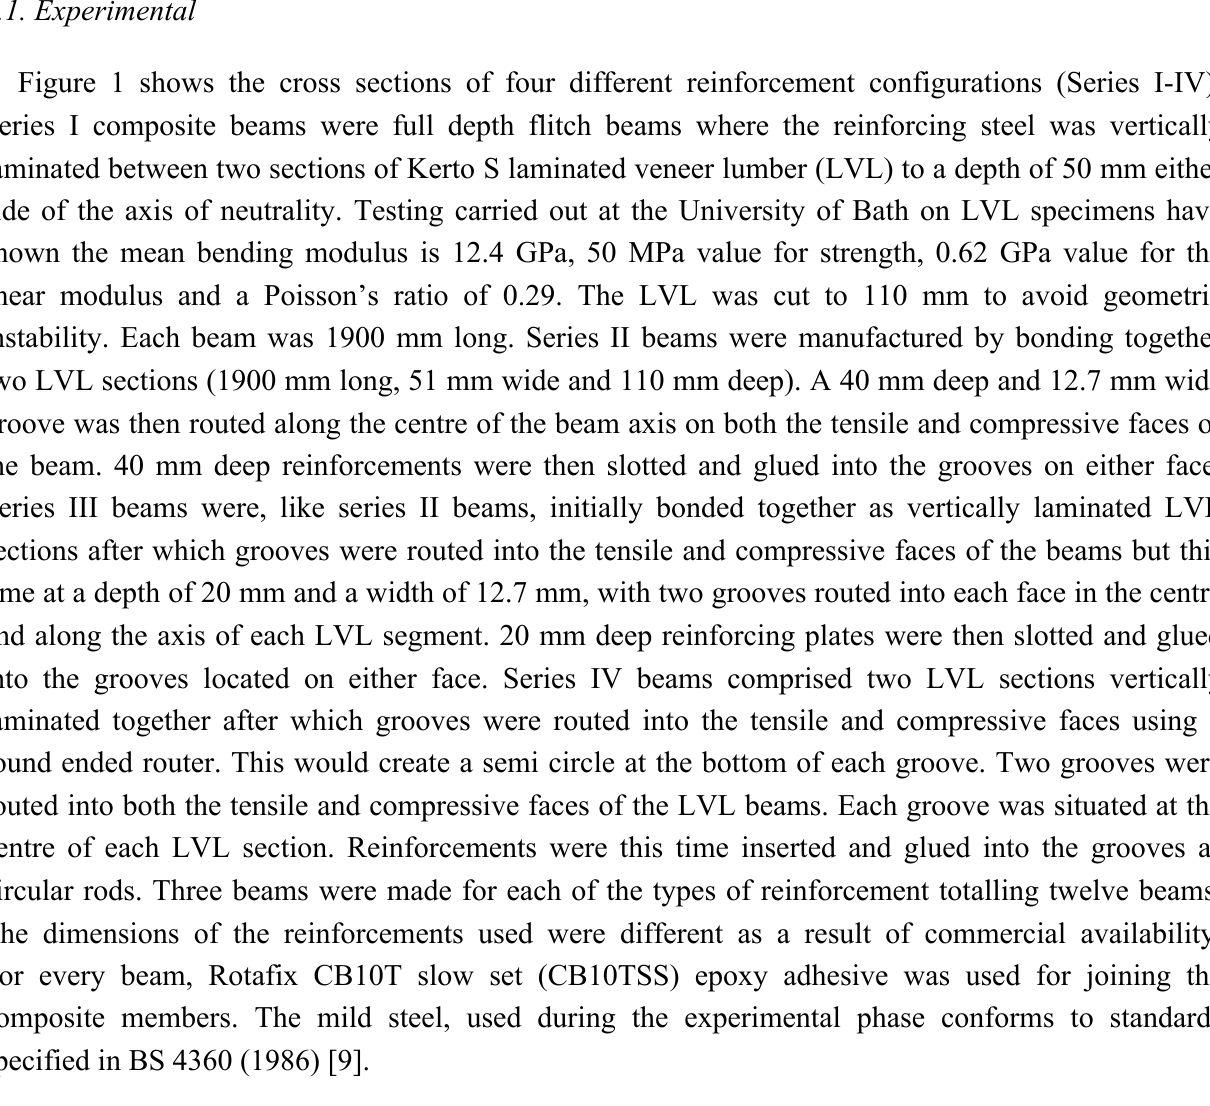
Figure 1. Composite beam reinforcement configurations for series I, II, III and IV.